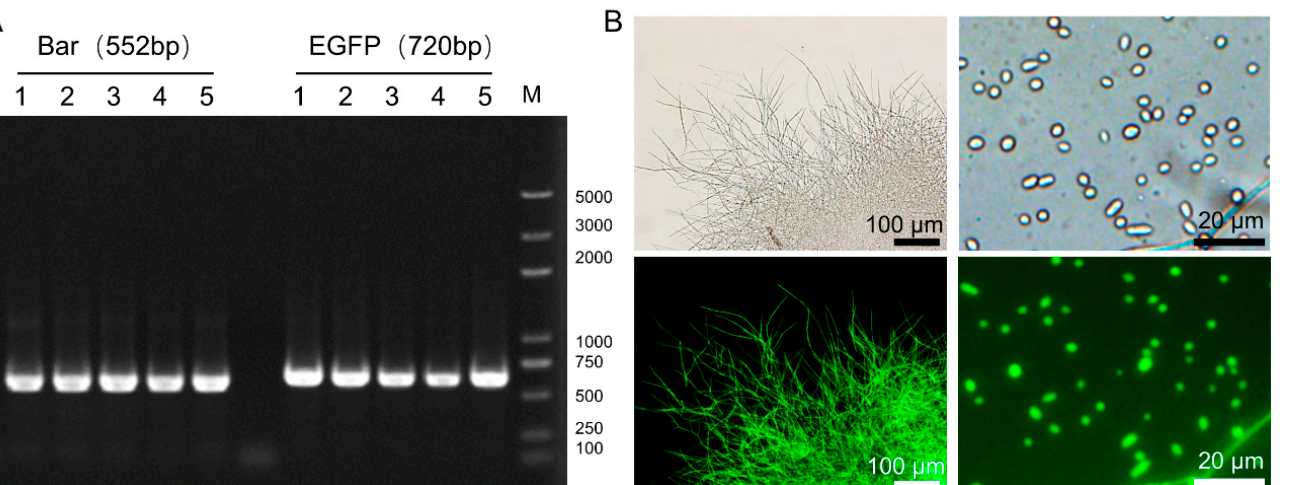
Figure 1. Promoter cloning and vector construction. ( A ) Cloning results of C. farinosa glyceraldehyde 3-phosphate dehydrogenase ( gapdh ) gene, using genomic DNA (gDNA) and complementary DNA (cDNA) as templates to clone the full-length and coding sequence (CDS) of the gene, respectively. ( B ) Cloning results of the gapdh gene promoter region of C. farinosa . ( C ) Schematic of constructed vector pCam-BE. The vector contained a selectable gene ( Bar ) and reporter gene (enhanced green fluorescent protein, EGFP ). The Bar gene was under the control of the Aspergillus nidulans anthranilate synthase multifunctional protein ( trpC ) promoter, and the EGFP gene was under the control of the gapdh promoter. The restriction enzyme sites used are also shown in the figure.